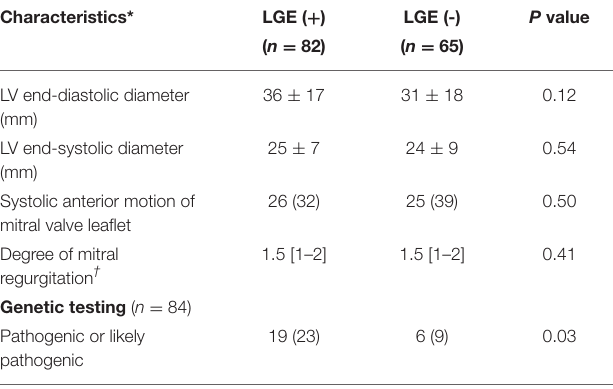
Table 2 ) in the test set. Based on the discrimination